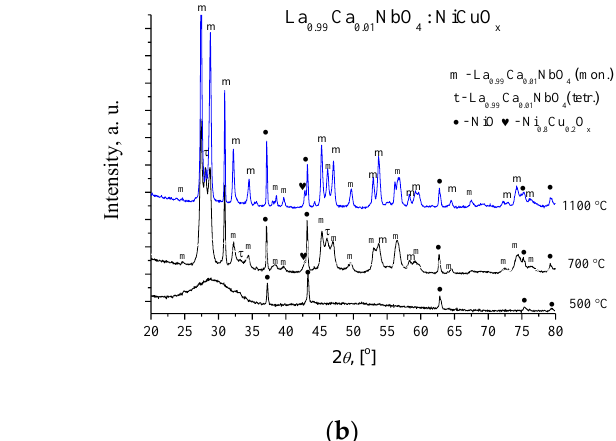
1100 °C. 500–1100 ◦